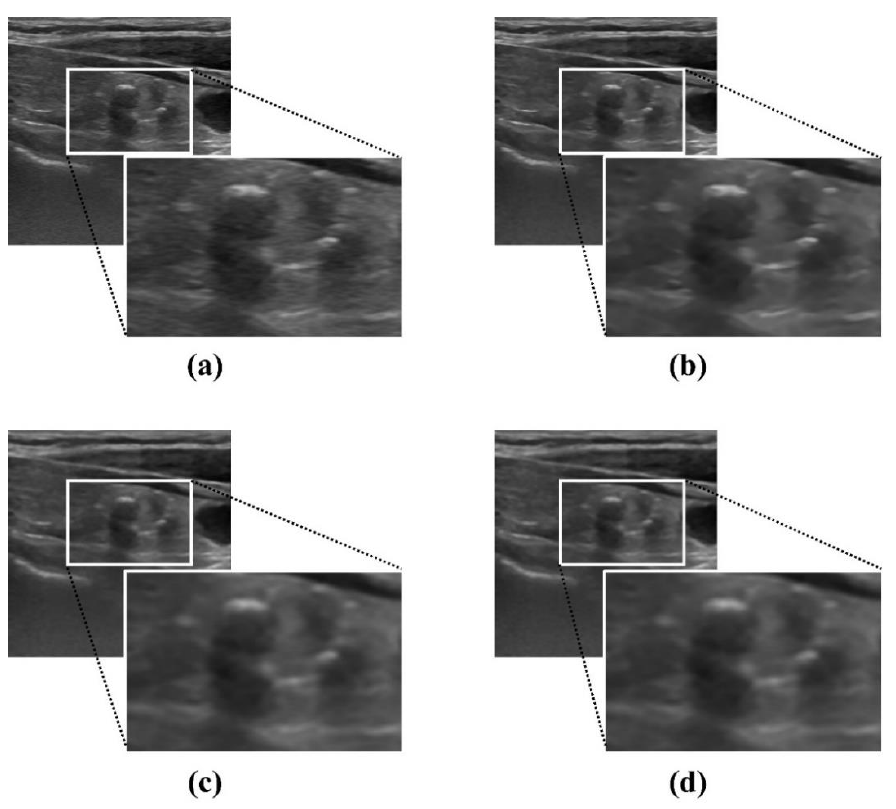
Figure 8. Ultrasound images of patients with thyroid nodule: ( a ) noisy image and NLM denoising with ( b ) low smoothing, ( c ) middle smoothing, and ( d ) high smoothing.